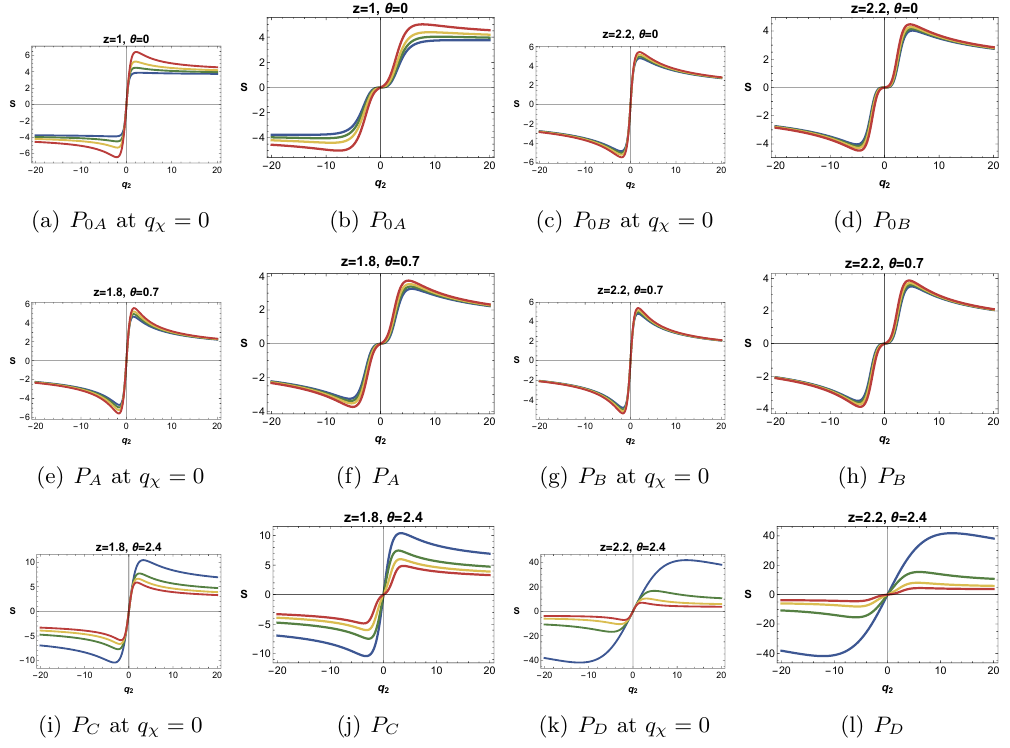
Figure 26 . Temperature evolution for S ( q 2 ) for di(cid:11)erent ( z; (cid:18) ). Each curves corresponds to T = 0 : 04 ; 0 : 1 ; 0 : 160 : 24 for blue, green, yellow, and red respectively. q (cid:31) = 5 if q (cid:31) 6 =